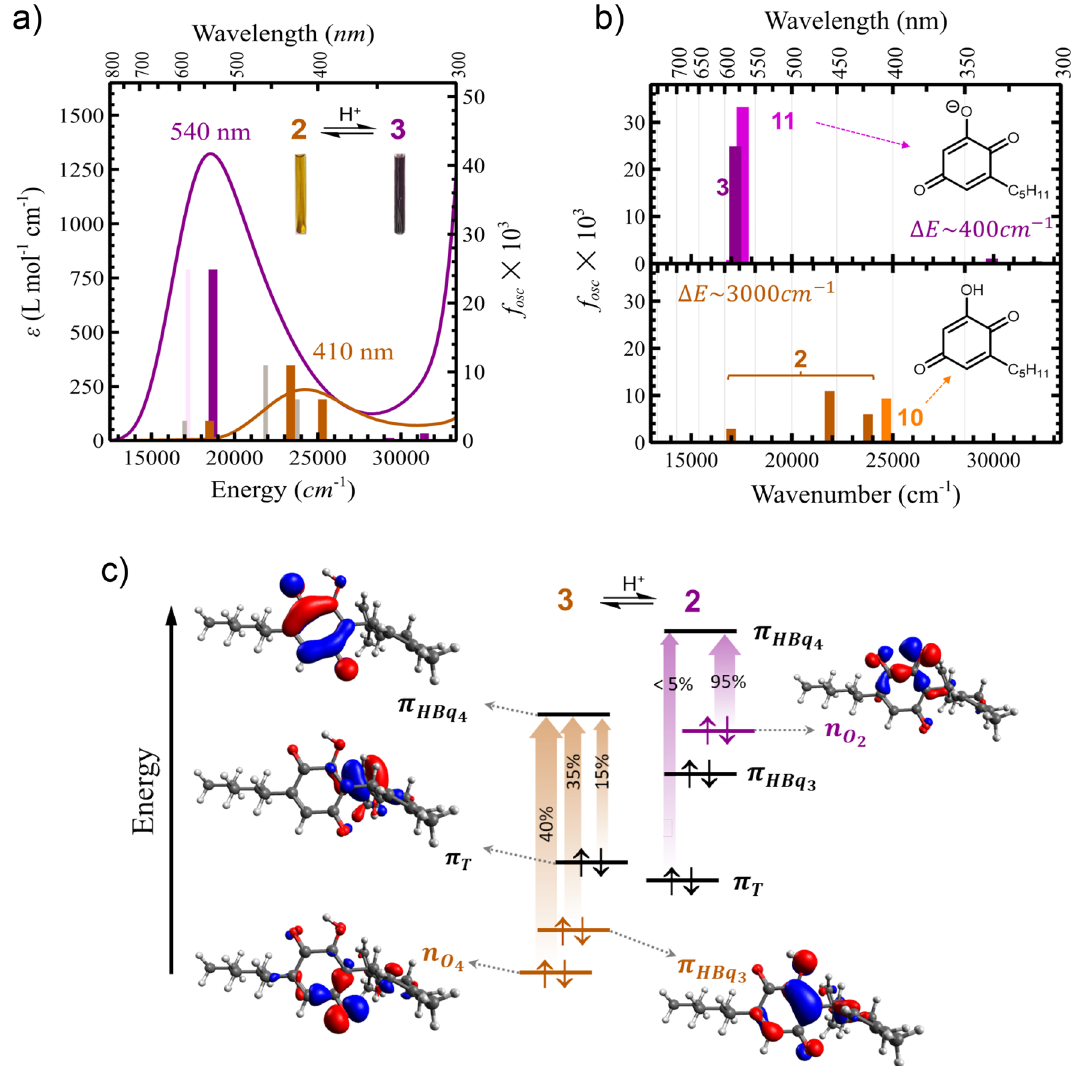
Figure 5. Purple colour origin in 2-hydroxyquinone anions. ( a ) Electronic absorption spectra in molar absorptivity ( ε ) and TD-DFT-computed oscillator strengths (f osc ) for 2 (orange) and its anion 3 (purple) in isopropanol. The simulated data were well matched to the experimental spectra by adding a small shift of + 1500 cm –1 . ( b ) Effect of the limonene group on the electronic absorption spectra based on TD-DFT calculations for both the neutral species ( 2 vs 10 ) and their anions ( 3 vs 11 ); the limonene group has a significant impact on the spectra of the neutral species but not the anions. ( c ) Simplified representation